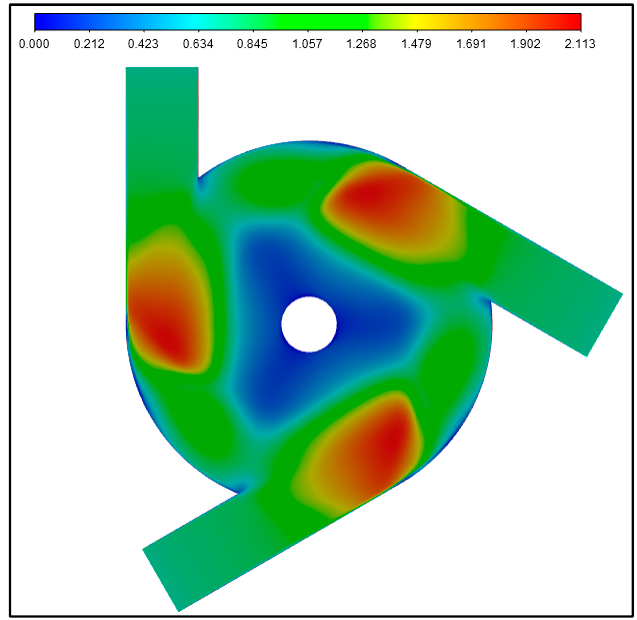
Figure 8. Countour of Mach number. The presence of viscosity in gases led to secondary swirls, as shown in Figure 9 (indicated by a black circle). The formation of secondary swirls occurs when the gas leaves the nozzle exit of SVT. He and Ar have the most significant swirl, i.e., flow velocity around the main streamline. On the other hand, the air has the slightest degree of swirl.